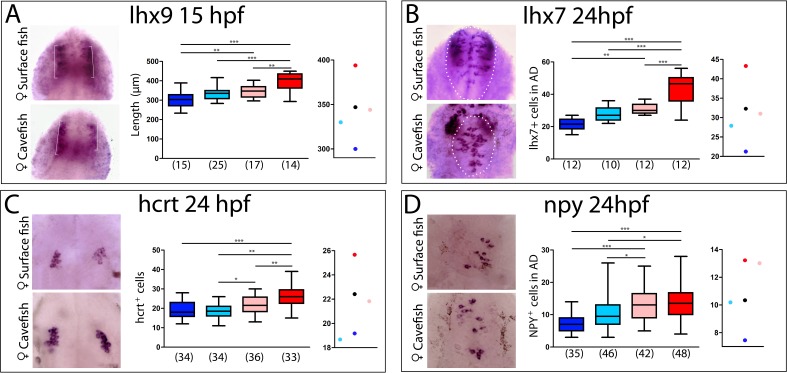
Maternal effect on the development of peptidergic systems.(A) Expression of lhx9 in HybSF (left, on top) and HybCF (left, on bottom) at 15 hpf. Quantification of the length of the expression domain in the prospective hypothalamus (white brackets) (center) and the corresponding plot of means distribution (right). (B) Expression of lhx7 in HybSF (left, on top) and HybCF (left, on bottom) at 24 hpf, with the acroterminal domain indicated in dashed lines. Quantification of the number of lhx7-expressing cells in the acroterminal domain (center) and the corresponding plot of means distribution (right). (C) Expression of hcrt HybSF (left, on top) and HybCF (left, on bottom) at 24 hpf. Quantification of the number of hypothalamic hcrt-expressing cells (center) and the corresponding plot of means distribution (right). (D) Expression of NPY in HybSF (left, on top) and HybCF (left, on bottom) at 24 hpf in the acroterminal domain. Quantification of the number of NPY-expressing cells (center) and the corresponding plot of means distribution (right). Kruskal-Wallis tests with Dunn’s post-test were performed in all cases.